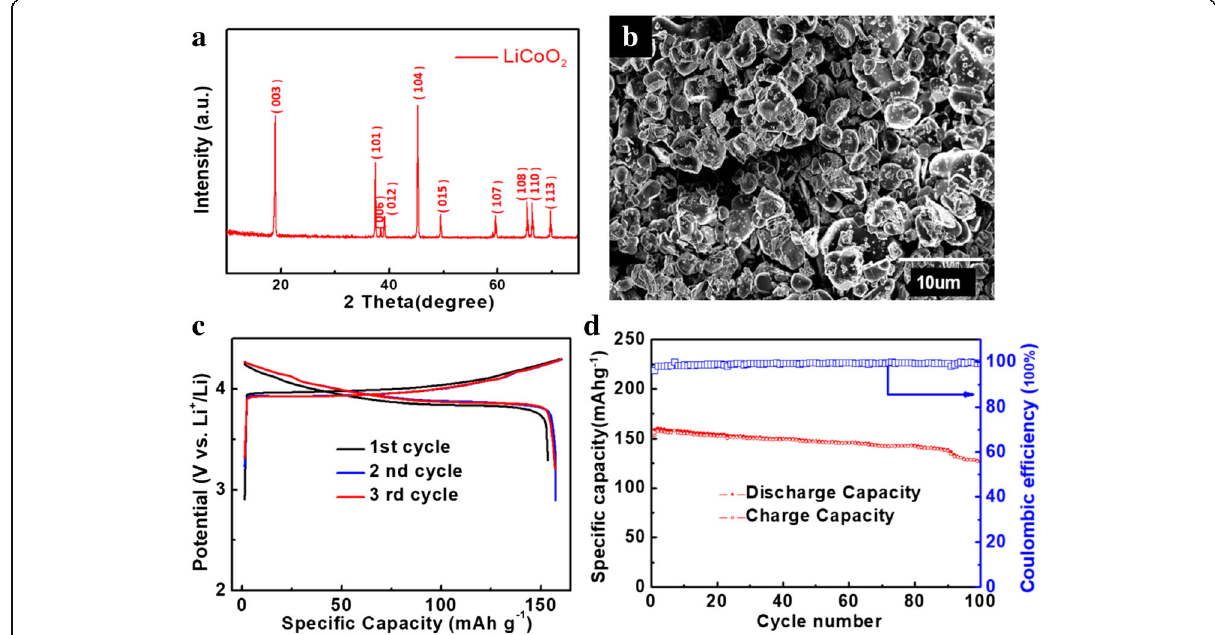
Fig. 3 a XRD pattern, b SEM image, c charge – discharge curves, and d cycling performance of LiCoO 2